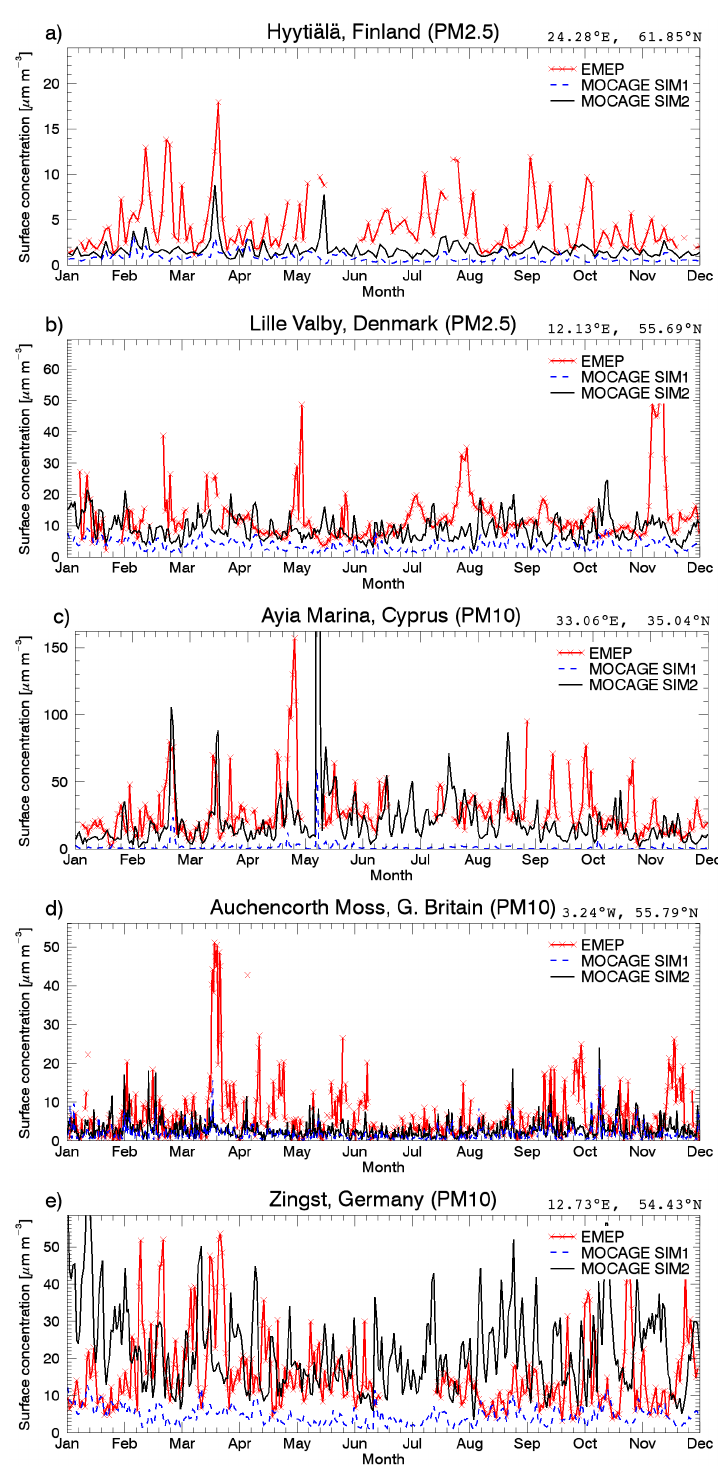
Figure 9. Time series of aerosol PM for 2007 from EMEP data, and for SIM1 and SIM2 for five EMEP stations: Hyytiälä, Finland (PM 2 . 5 , 24.28 ◦ E, 61.85 ◦ N), Lille Valby, Denmark (PM 2 . 5 , 12.13 ◦ E, 55.69 ◦ N), Ayia Marina, Cyprus (PM 10 , 33.06 ◦ E, 35.04 ◦ N), Auchencorth Moss, Great Britain (PM 10 , 3.24 ◦ W, 55.79 ◦ N) and Zingst, Germany (PM 10 , 12.73 ◦ E, 54.43 ◦ N). Correlation, modified normalized mean bias and fractional gross error for both SIM1 and SIM2 compared to EMEP observations are given in Table 3. The descriptions of the model simulations are in Table